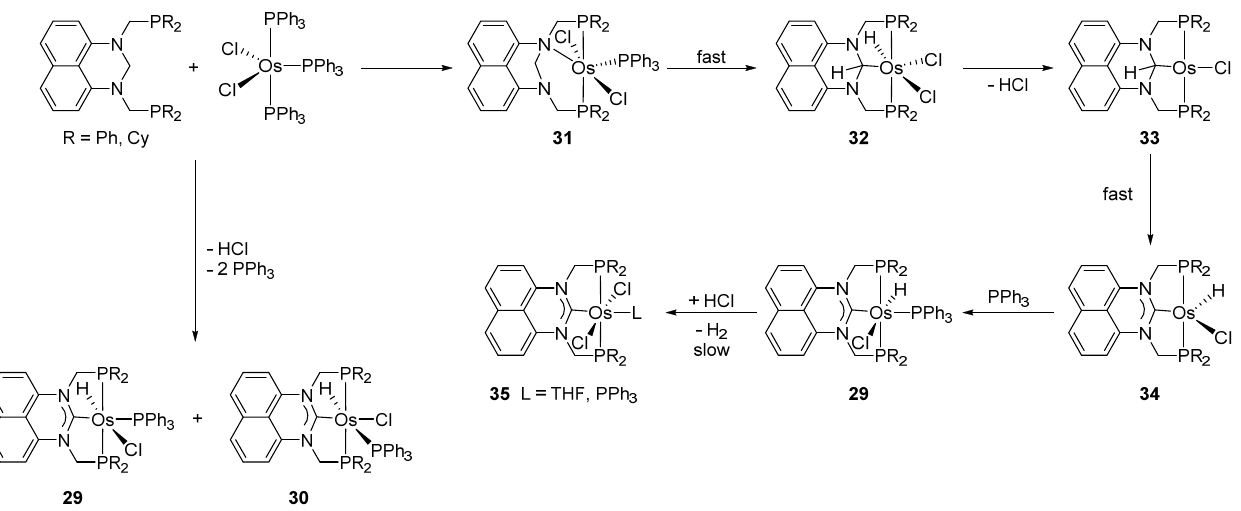
Figure 8. Synthetic route for a series of P~C~P pincer complexes by a double C − H activation.